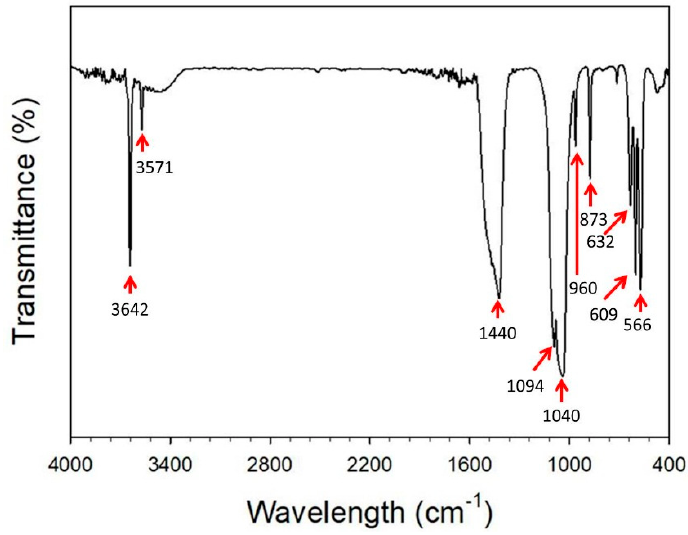
Figure 3. FTIR spectra of the fibers calcined at 800 °C under an N 2 atmosphere.